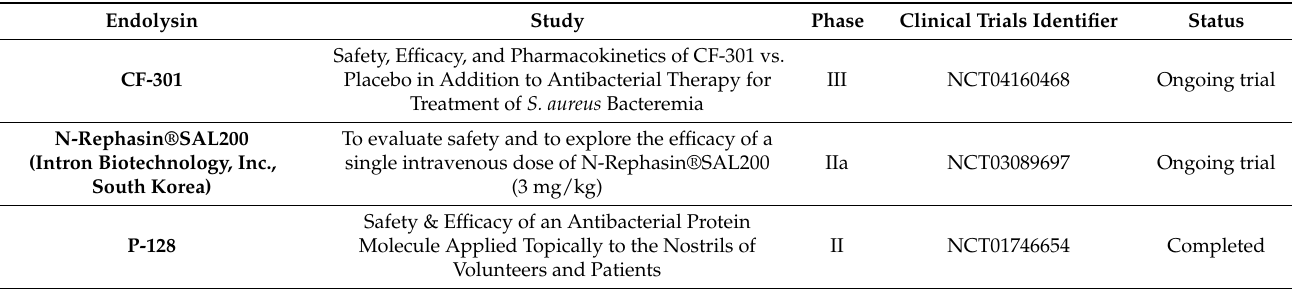
Table 2. List of endolysins in human clinical